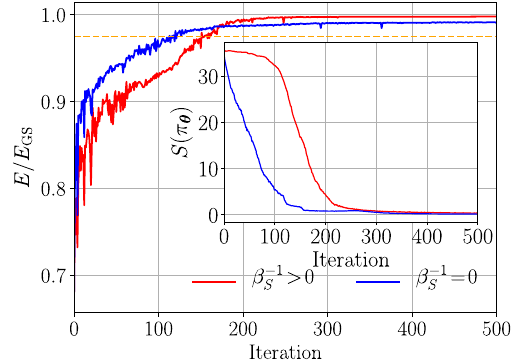
FIG. 13. Spin-1 Ising model: comparison of the mean reward with ( β − 1 S; ¼ 0 . 1 ) and without ( β − 1 S ¼ 0 ) the entropy bonus f 0 g during training. For comparison, the dashed horizontal line marks the performance of QAOA. The inset shows the evolution of the policy information entropy during training. Adding entropy gives more room for the RL agent to explore the space of policies instead of directly exploiting the knowledge it obtains. As becomes clear from the figure, the RL algorithm with the entropy bonus achieves a better final performance at the end of training, at the cost of suffering an intermediate lower reward at the beginning of training. The simulation parameters are the same as in Fig. precise, the learning rate at the k th iteration with the exponential decay reads as α ¼ 0 . 01 × 0 . 96 b k= 50 c . The lr ; f k g subscript f k g denotes the iteration or episode number.